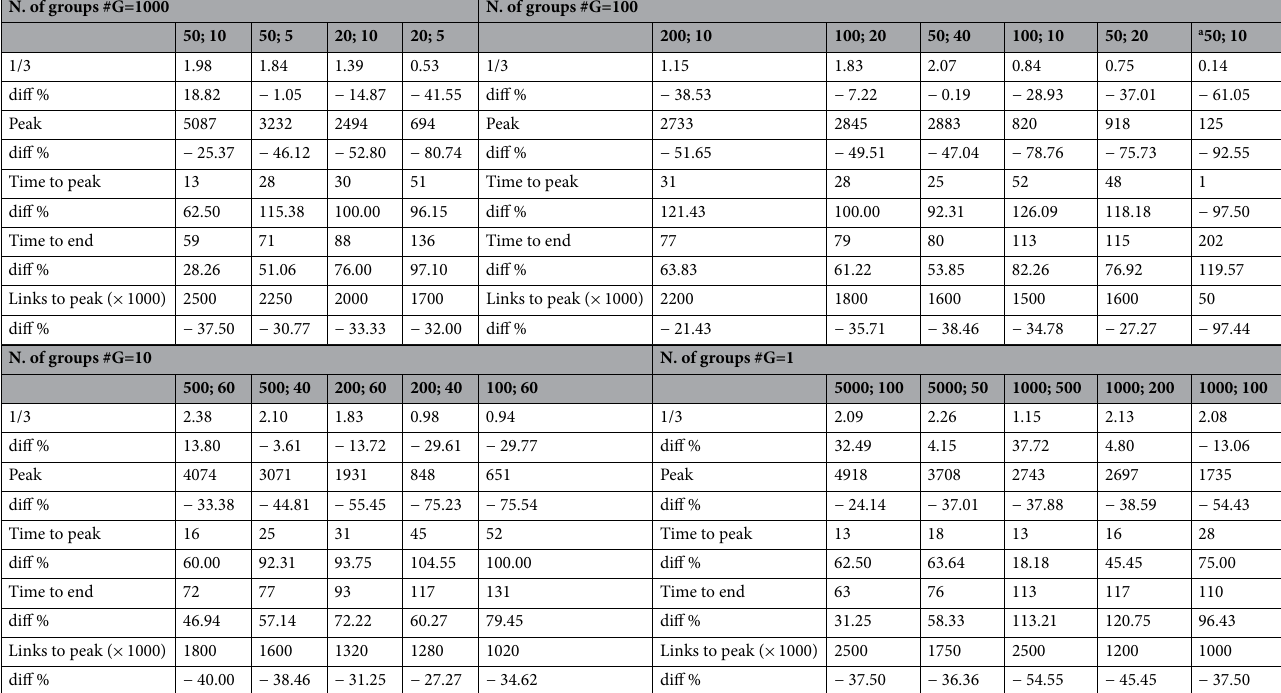
Table 2. Table layout is similar to Table 1. For each quadrant, the values of the first row are those of the K eff ( × 1000 ) index for the non-consecutive grouping pattern with f = 1 / 3 . The following diff % row, show the percent difference with the corresponding values of average efficiency, ( avg. ) row of Table 1. All other diff % rows refers to corresponding rows of Table 1. a Series 50, 10 for f = 1/3 produces a negligible second